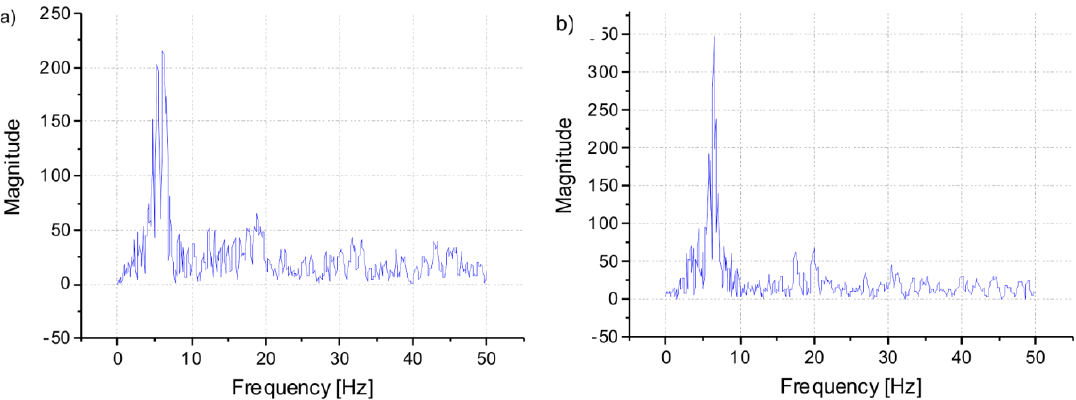
Figure 7. Recorded BES frequency spectrum activated by muscle tension inside the head: ( a ) pressing the tongue, ( b ) clenching of jaws.